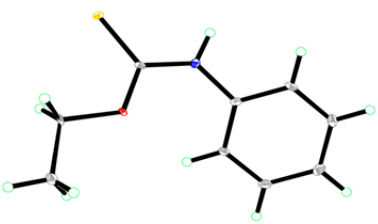
Figure 4. ORTEP diagram of compound 4 . Displacement ellipsoids are plotted at the 40% probability level for non-H atoms. Table 1. Experimental details of compound 4 .